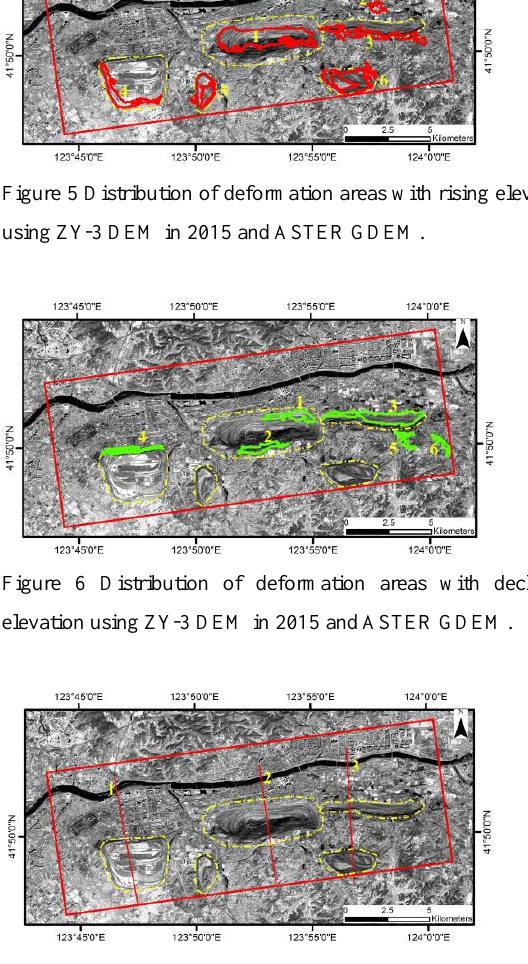
Figure 7 Location of three profiles in this area. Profile 1 crosses West Waste Rocks Piling Field; Profile 2 crosses the West Open Mine; Profile 3 crosses East Open Mine and East Waste Rocks Piling Field.